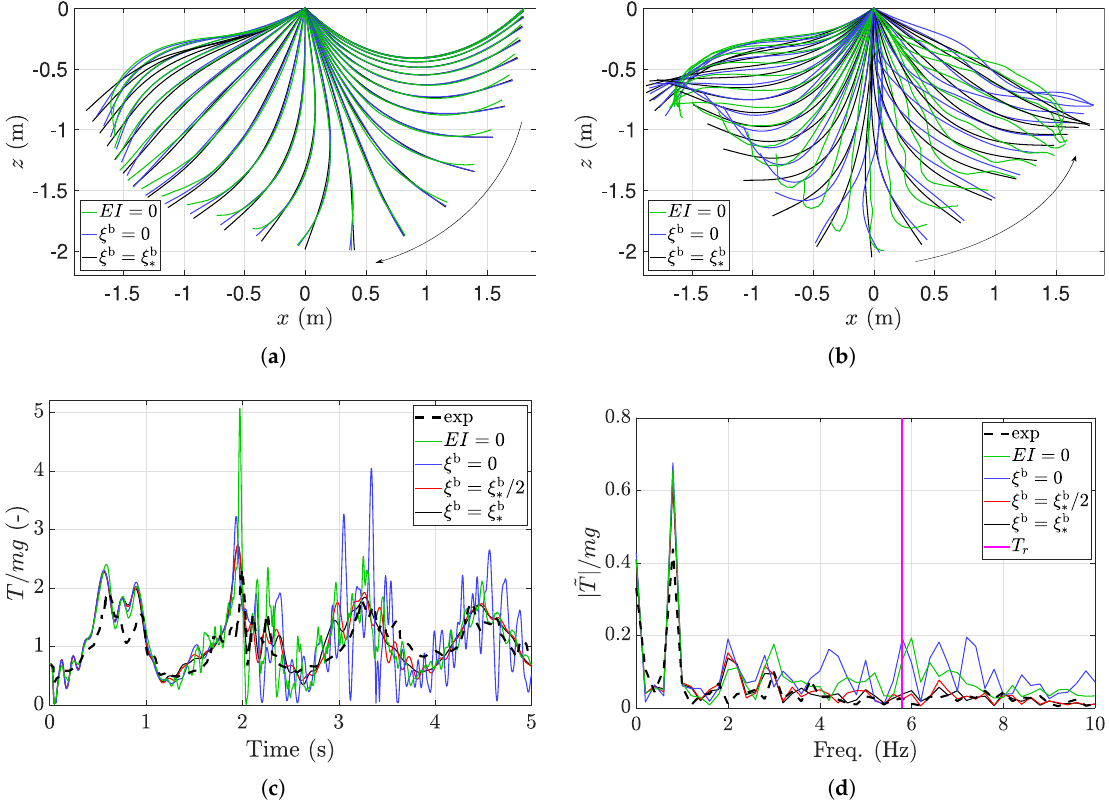
Figure 3. Results of the cable swing test for different cable material properties. ( a , b ) Cable position every 0.05 s during the first swing ( a ) t ∈ [ 0, 1.25 ] s and the second swing ( b ) t ∈ [ 1.25, 3 ] s of the cable. In ( c ), we see the force recorded at the strain gauge position, and ( d ) shows the Fourier decomposition of the force